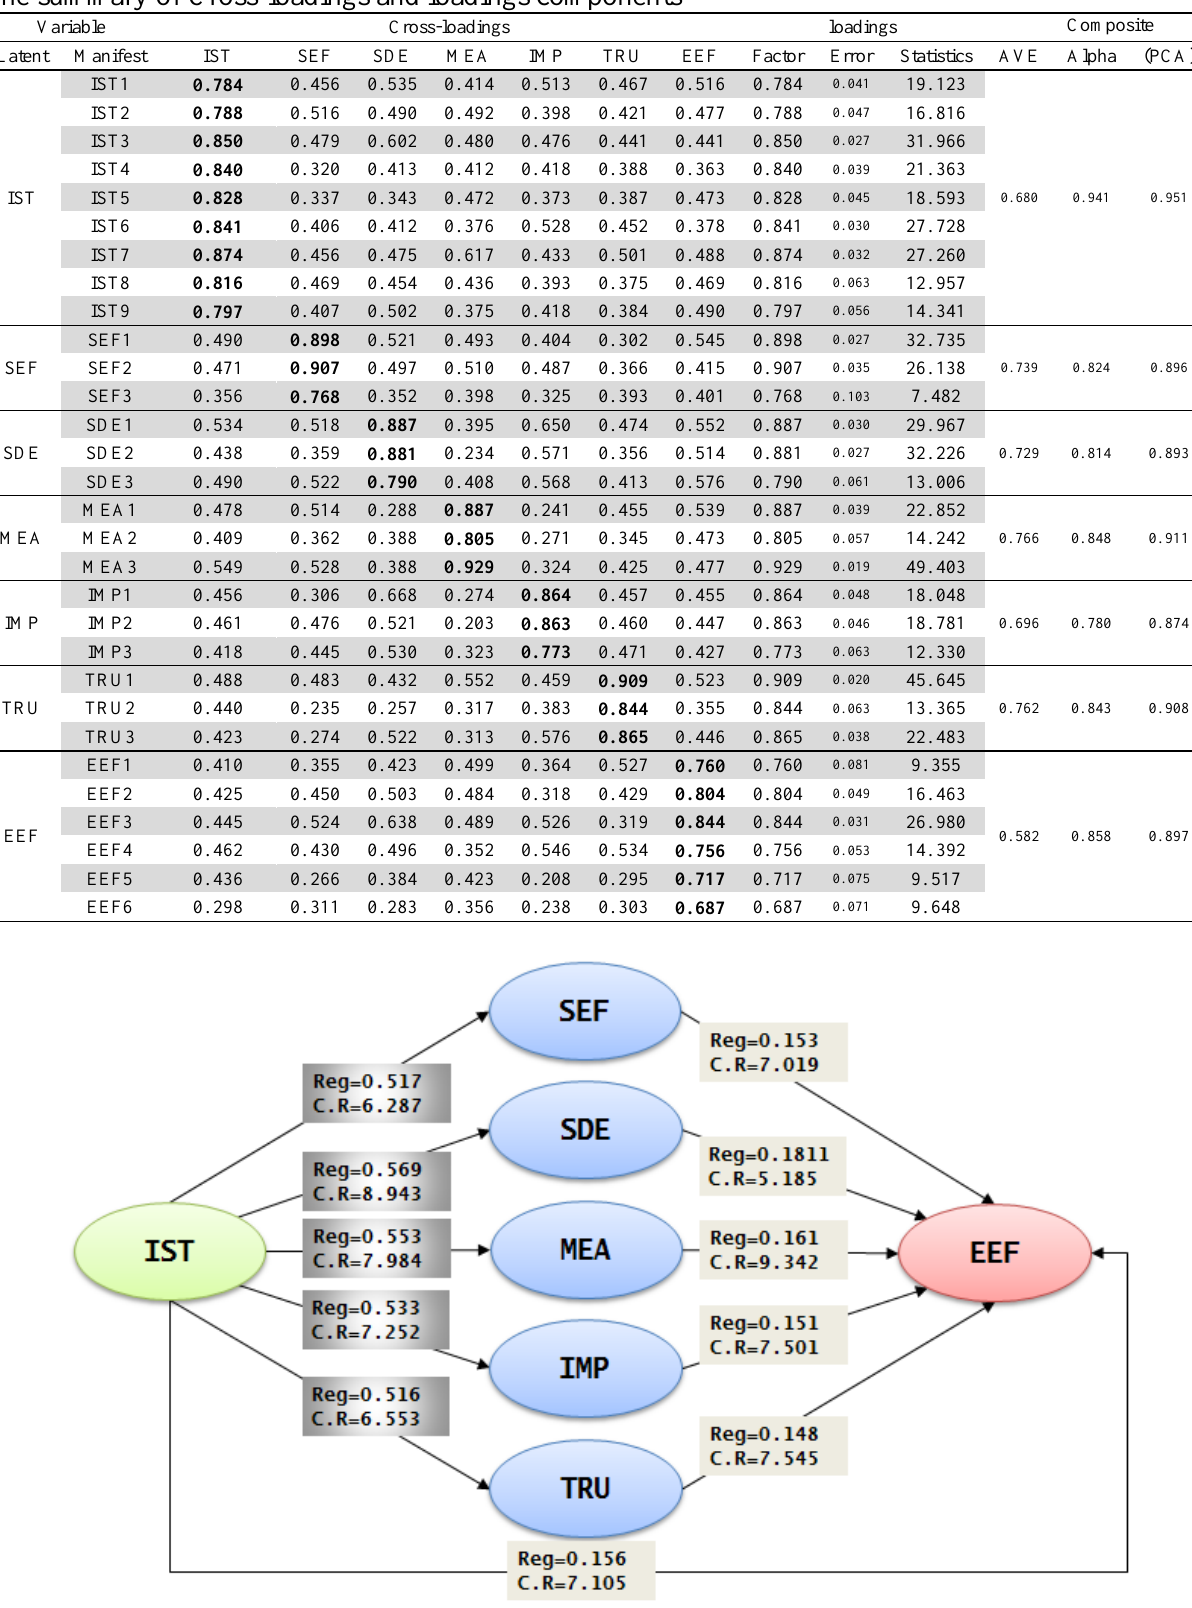
Fig. 2. The summary of structural equation